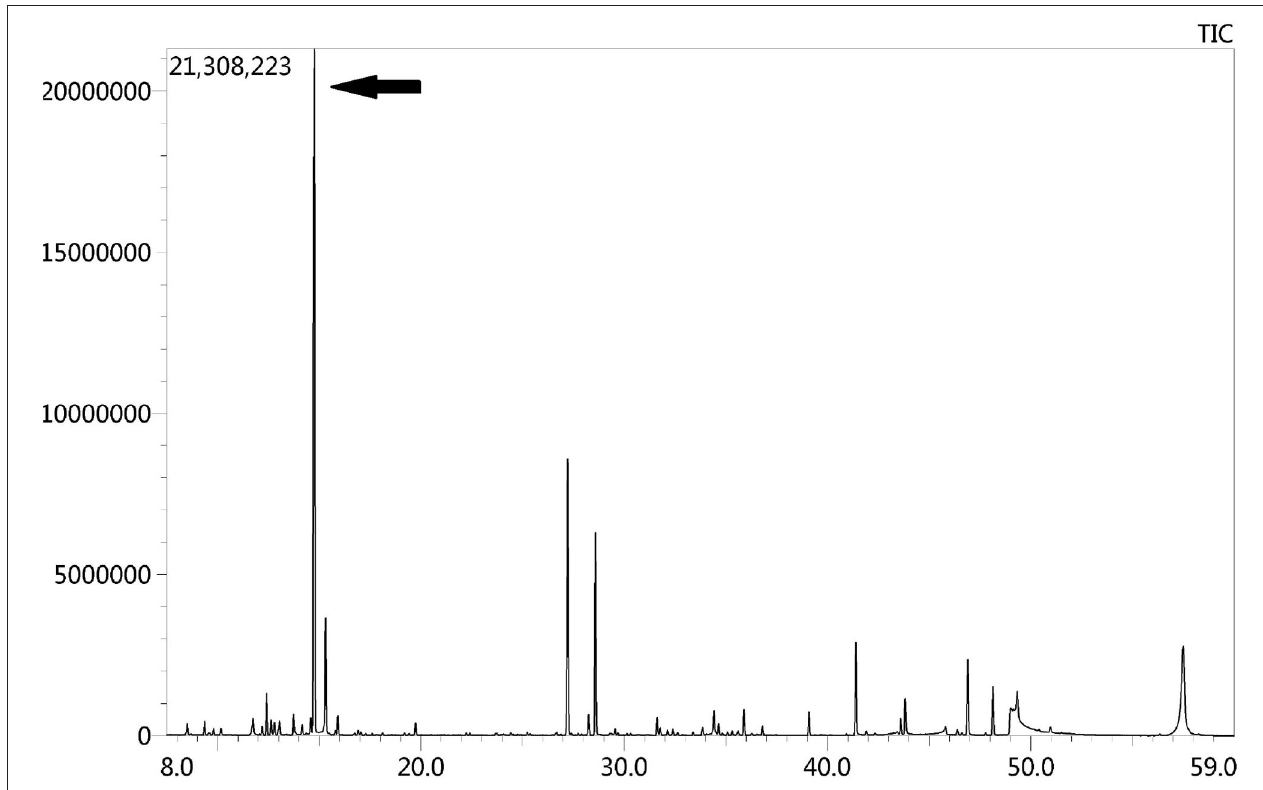
FIGURE 2 | GC-MS urinary organic acid profile. The arrow showed spectrum of elevated methylmalonic acid, which was 100 times higher than normal